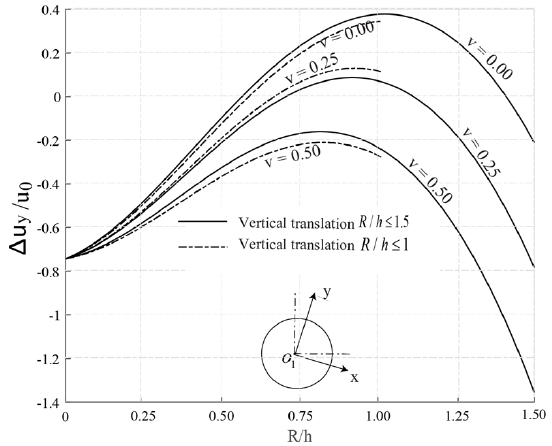
Figure 10. Vertical translation of the tunnel wall.